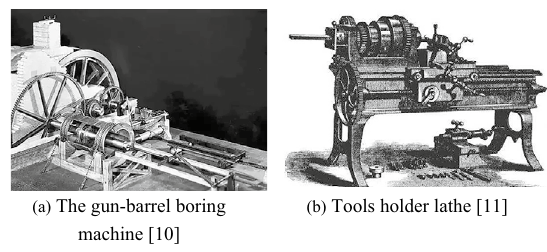
Figure 3 Typical machine tools in the mechanization age: a The gun-barrel boring machine [10]; b Tools holder lathe